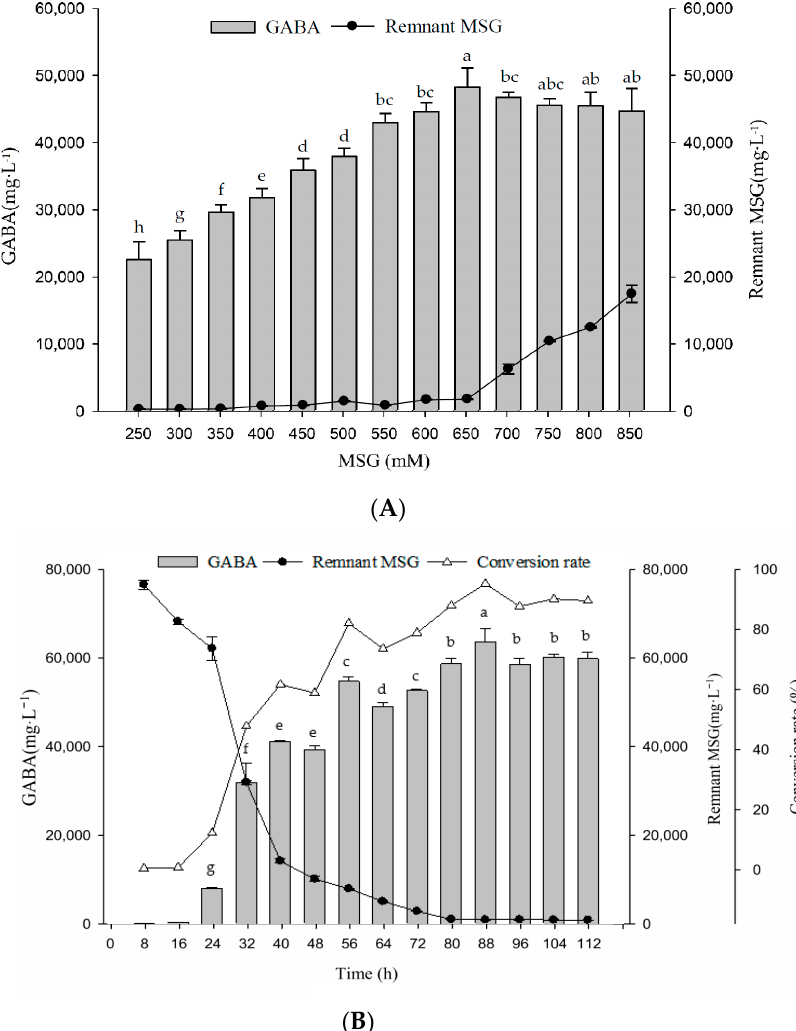
Figure 4. The effect of different amount of MSG in G broth on GABA production. ( A ) Bacterial cells were grown in 500 mL G broth with different concentrations of MSG for 96 h at 30 °C. G broth contains 1% glucose, 2.5% yeast extract, 2 ppm calcium carbonate, 2 ppm manganese sulfate, 2 ppm Tween 80 and 10 uM PLP. Different lowercase letters indicate statistically significant differences of GABA production. ( B ) Bacterial cells were grown in 2 L G broth with 650 mM MSG (GM broth) in 3 L flasks at 30 °C for 112 h. Data are expressed as mean ± SD from triplicate experiments. Different letters at the top of the bars are significantly different ( p < 0.05).